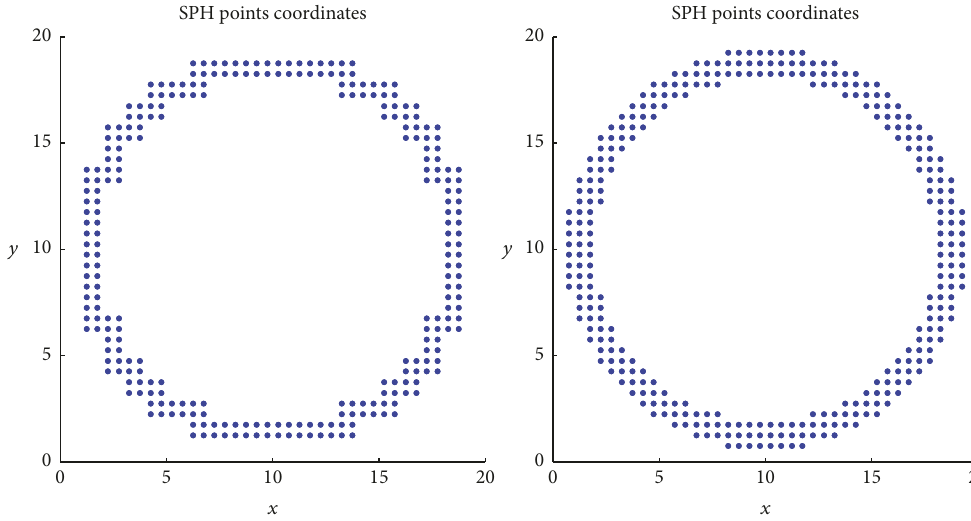
Figure 3: Coarse and refined discretizations of the sphere for 𝜙 = 0.45 (a central cut). Table 2: Numerical error for permeability of periodic arrays of spheres for various 𝜙 values, solid sphere discretizations, and interparticle spacing as compared to 𝐾 𝑎 .